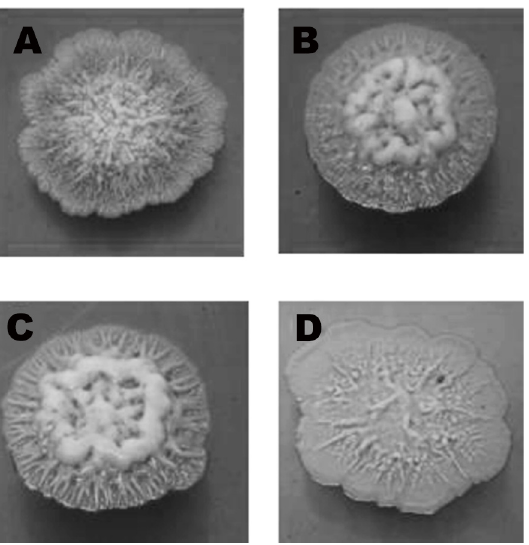
Fig 2. Colony morphology of B . pseudomallei . Colony morphology of the strains was observed after incubation at 37°C for 7 days. The rpoS (B), ppk (C), and bpsI (D) mutants which contained each single gene mutation in rpoS , ppk , and bpsI genes, respectively, showed distinct morphology from the wild-type